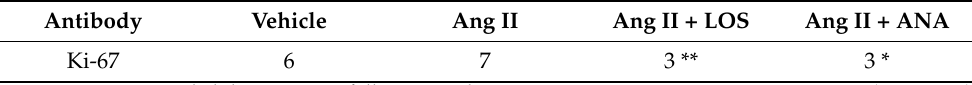
Figure 10. LOS Inhibits Ang II-induced tumor growth of U-87 MG xenografts. ( A ) U-87 MG glioblastoma cells were injected subcutaneously in female nude mice (five mice per group) and then treated with vehicle ( − ), Ang II alone, or in combination with LOS or ANA. Relative tumor volume (RTV) was calculated by the following formula: RTV = (Vx/V1) where Vx is the tumor volume on day x and V1 is the tumor volume at initiation of treatment (day 0). y-axis: means ± SD of the RTV. ( B ) Images of representative individual tumors and average tumor weight from vehicle ( − ), Ang II alone, or in combination with LOS or ANA. ( C ) Hematoxylin and eosin (H&E) staining of tumor sections from vehicle ( − ), LOS and Ang II alone, or in combination with LOS or ANA. ( D ) Immunohistochemical analysis in U-87 MG xenograft tumor of Ki-67, Arom, upon Ang II treatment w/o LOS or w/o ANA and both LOS and ANA. Scale bars = 12.5 µ m. * p < 0.05; ** p < 0.01; *** p < 0.001. Table 1. Immunostaining scores (Allred score median) of Ki-67 in U-87 MG xenograft treated with Ang II alone or in combination with LOS or ANA or ICI.